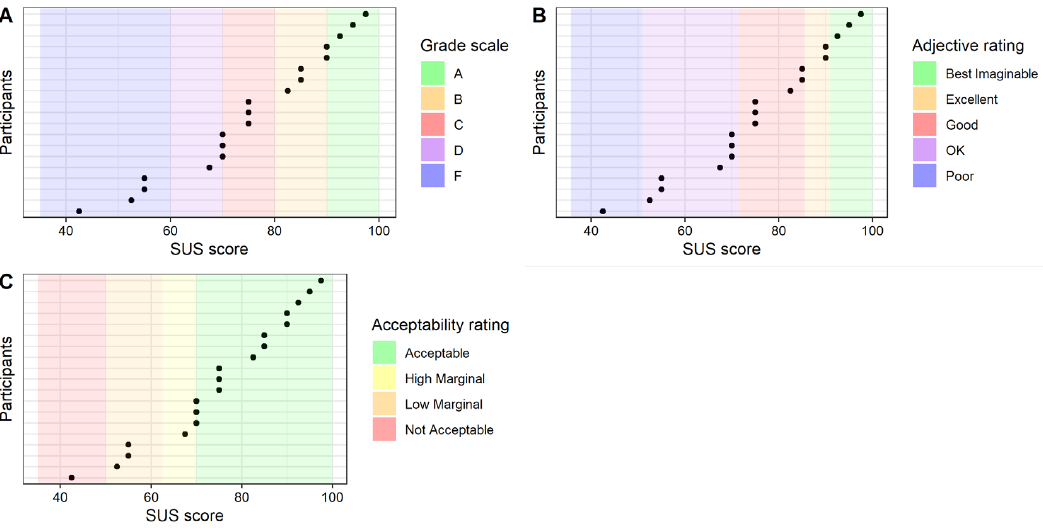
Figure 8. SUS score per participant: ( A ) grade scale, ( B ) adjective rating, and ( C ) acceptability rating.